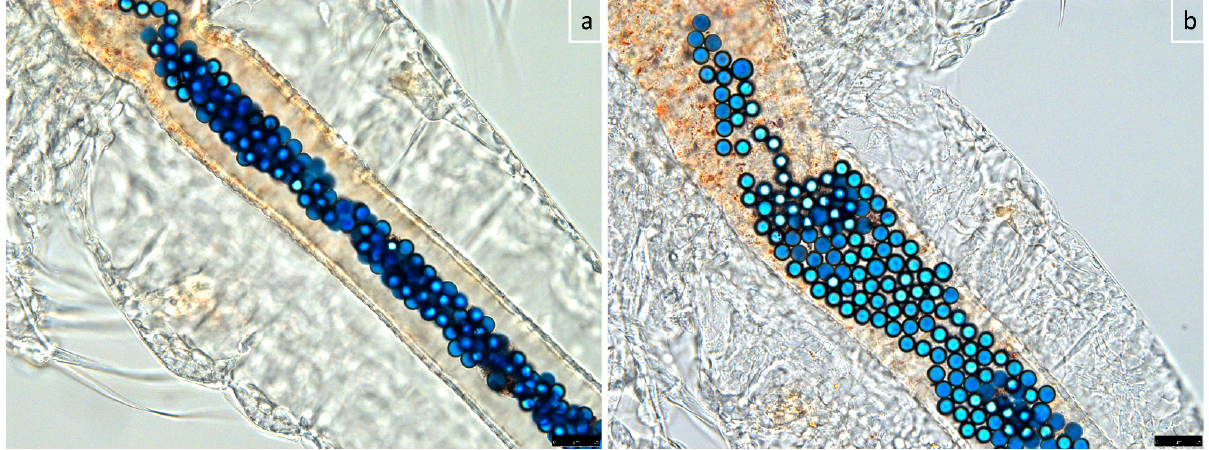
Figure 1. Ten µm of Polybead ® Blue Dyed Microspheres ingested by a Group B Artemia salina specimens at T96 treatment B5 (10 4 MPs/mL). ( a ) Normal view; ( b ) view of the same specimen gently crushed with the cover slide. Scale bars: 25 µm.